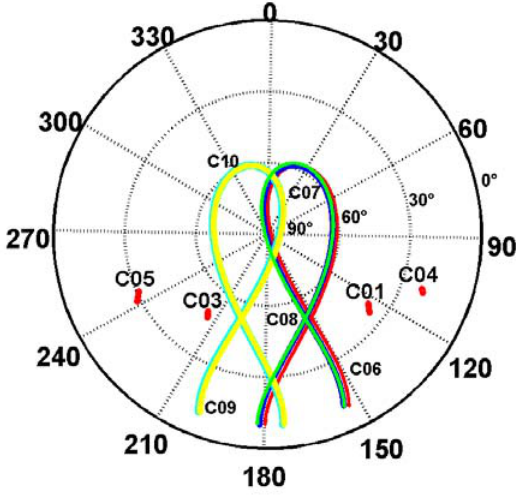
Figure 3. Sky plots (azimuth vs. elevation) of five IGSO and four GEO satellites at CHDU on September 24,